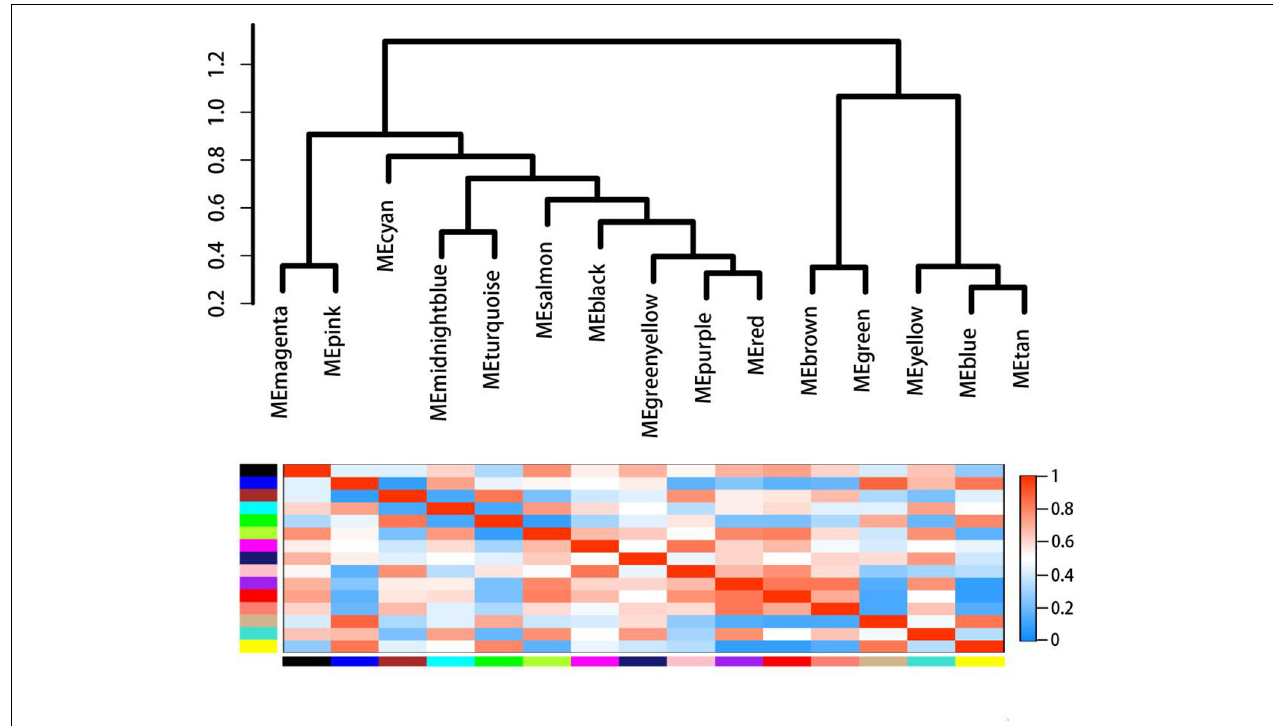
FIGURE 7 | Gene co-expression modules in MeJA-treated rhizomes showing the cluster dendrogram constructed based on the eigengenes of the modules (above) and the heatmap for the correlation coefficient between the modules (below).